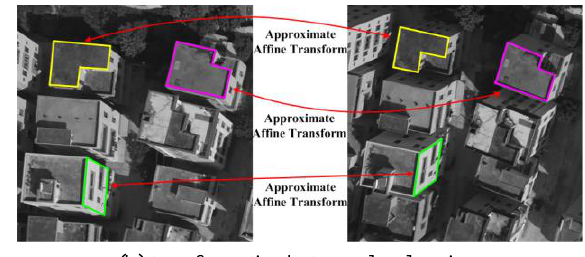
Figure 2. Image geometric transformation.